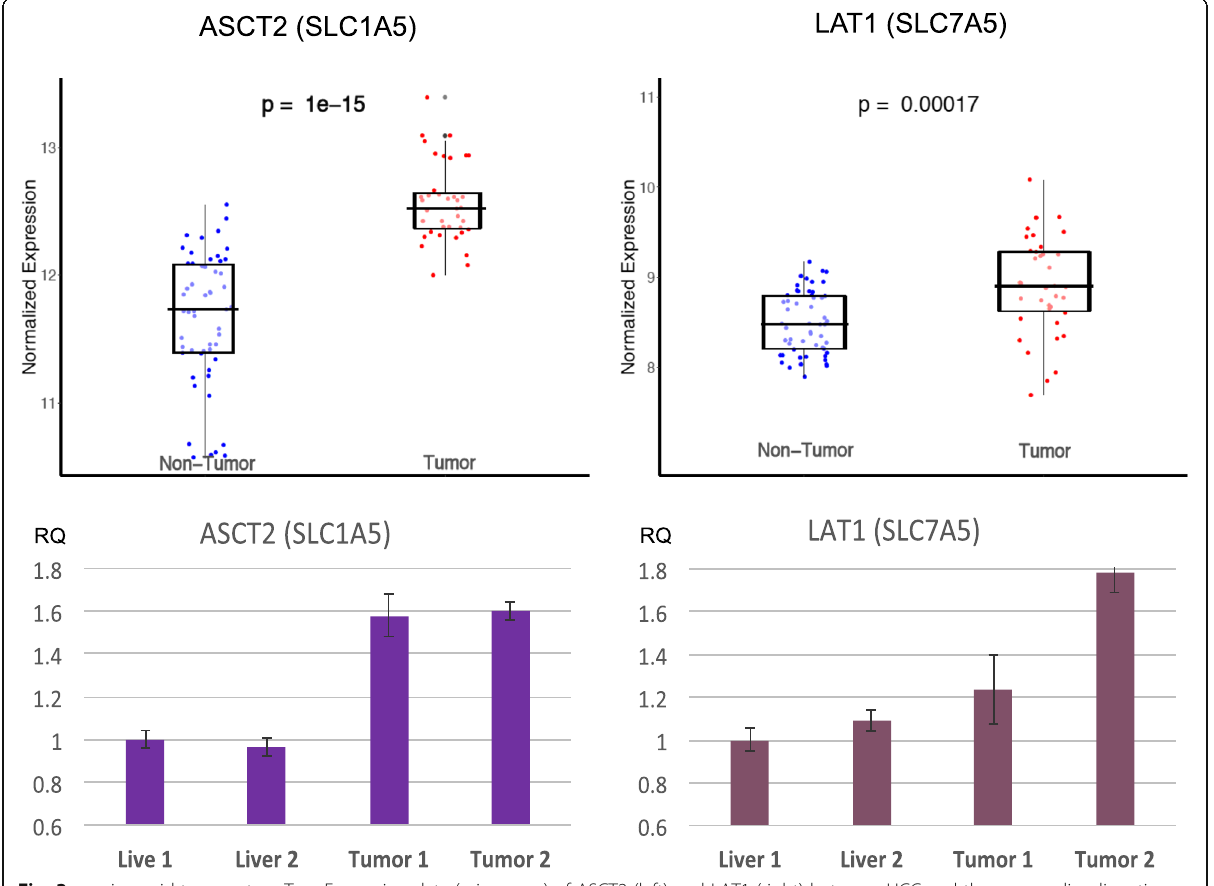
Fig. 3 L -amino acid transporters. Top: Expression data (microarray) of ASCT2 (left) and LAT1 (right) between HCC and the surrounding liver tissues from the woodchucks. Bottom: qRT-PCR data of ASCT2 (left) and LAT1 (right) of sampled liver and tumor